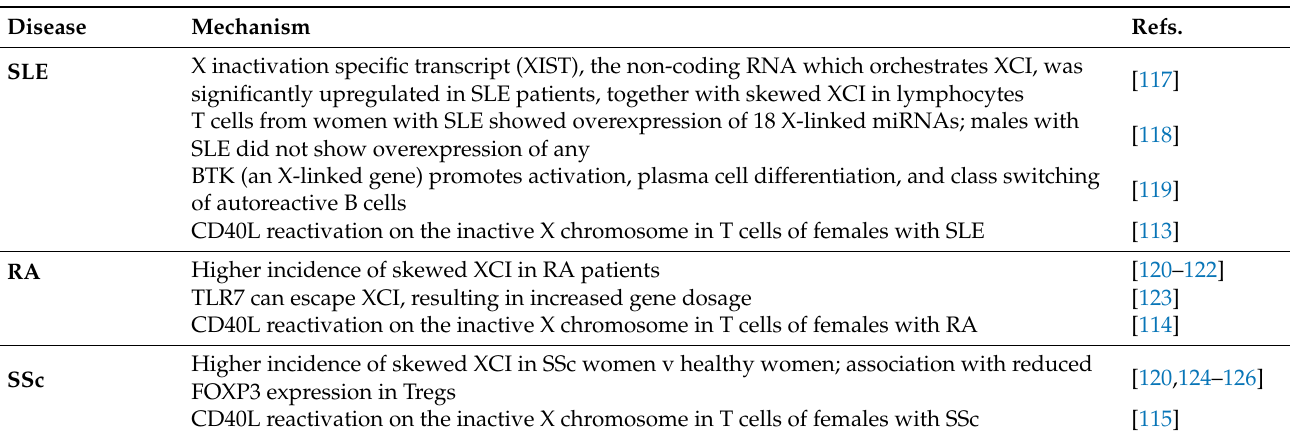
Table 3. X chromosome links to the pathogenesis of